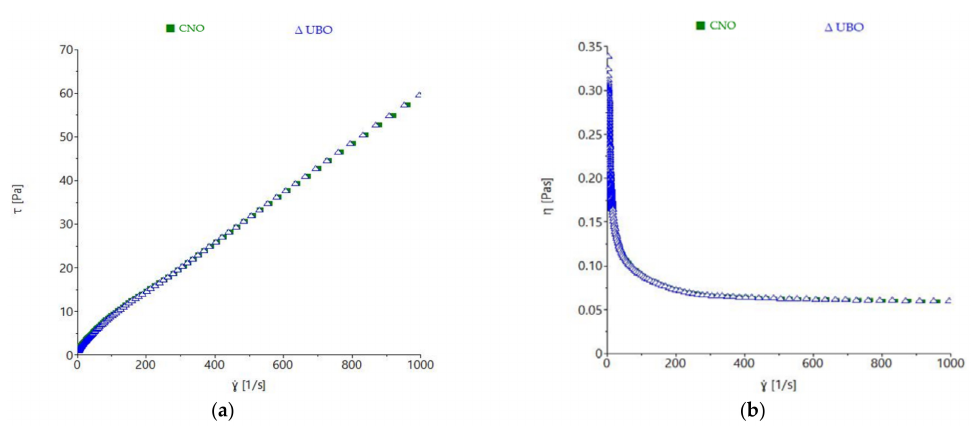
Figure 8. Influence of shear rate on ( a ) shear stress and ( b ) viscosity of UBO ( U. barbata extract in canola oil) and CNO (canola oil).